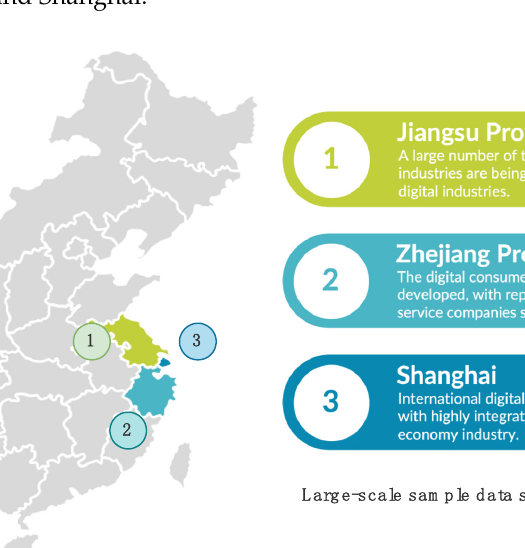
Figure 4. Location of the Yangtze River Delta region.